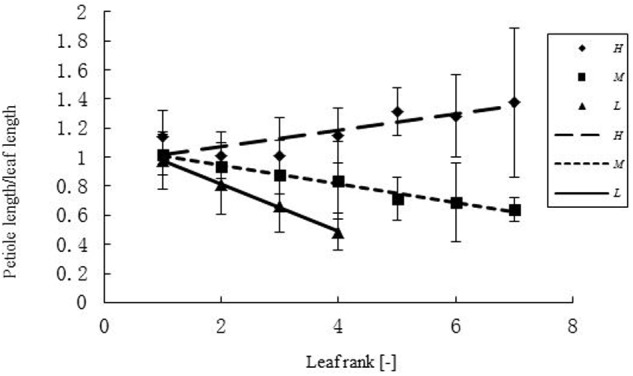
Differences in petiole length – leaf blade length ratio (PBR) of leaves at different ranks under three temperature treatments.
H, M, and L represent the plants under high, medium, and low temperature treatment, respectively. The ratio of petiole length and leaf blade length (PBR) differed between temperature treatments for different ranks r. For the high temperature it was: PBR = 0.056r + 0.9591 (R2 = 0.6925, n = 108); for the medium temperature: PBR = -0.0636r + 1.0704 (R2 = 0.979, n = 111); for the low temperature: PBR = -0.1609r + 1.1353 (R2 = 0.9985, n = 63).